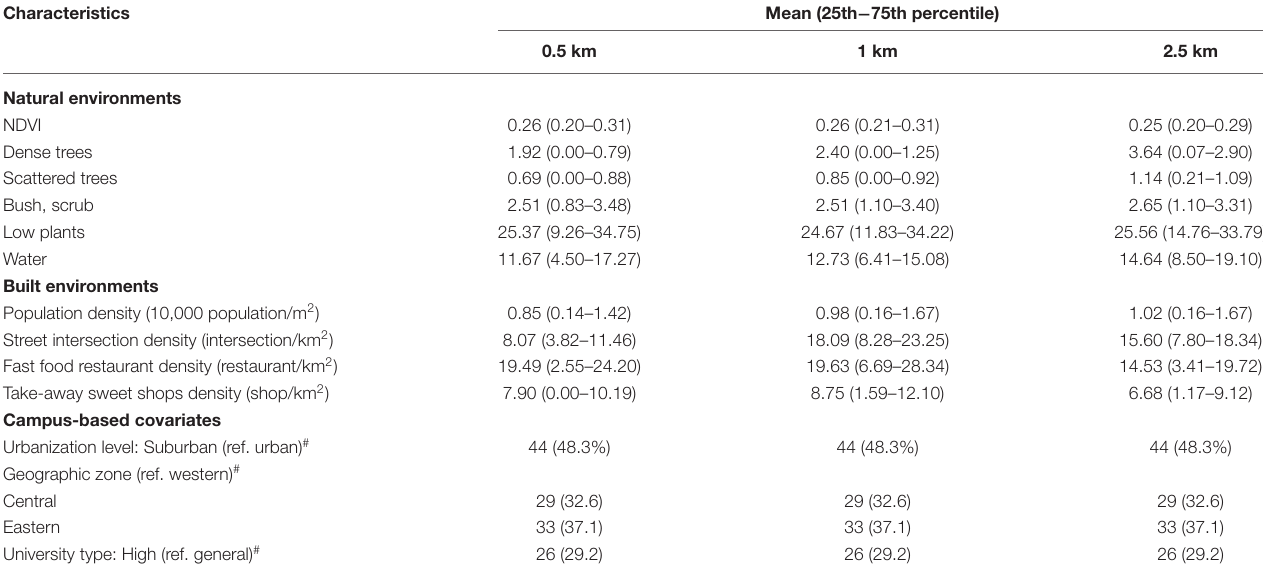
TABLE 2 | Descriptive statistics of natural-built environmental features surrounding 89 campuses.